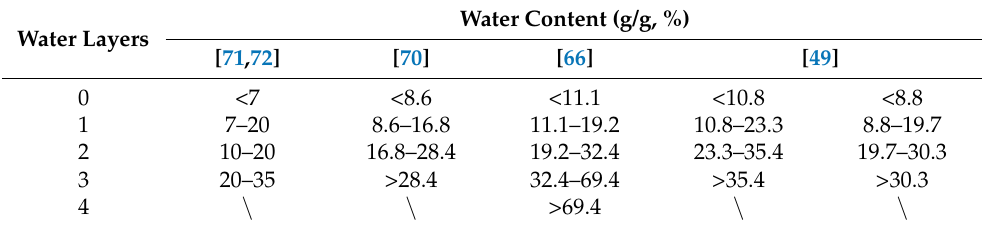
Table 2. The number of water layers with increasing water content for bentonite. Water